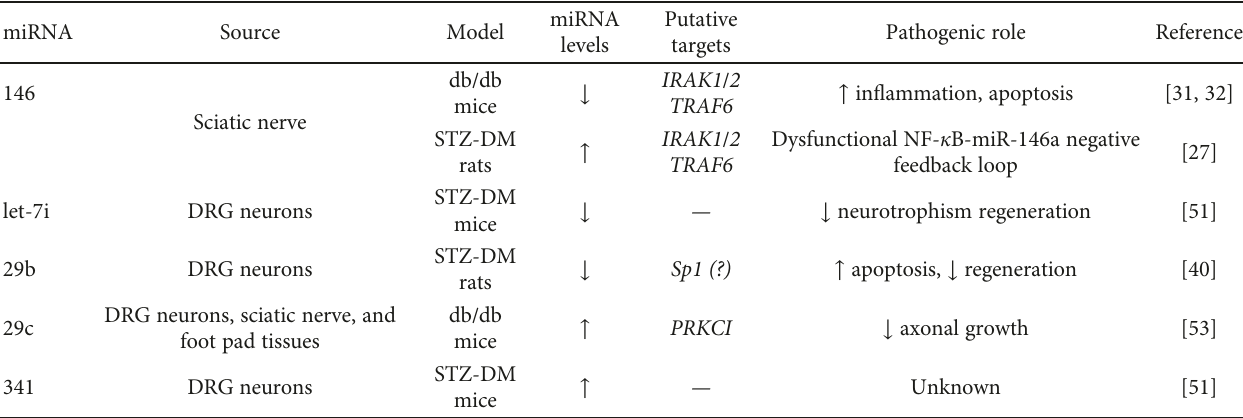
Table 3: MicroRNAs involved in diabetic